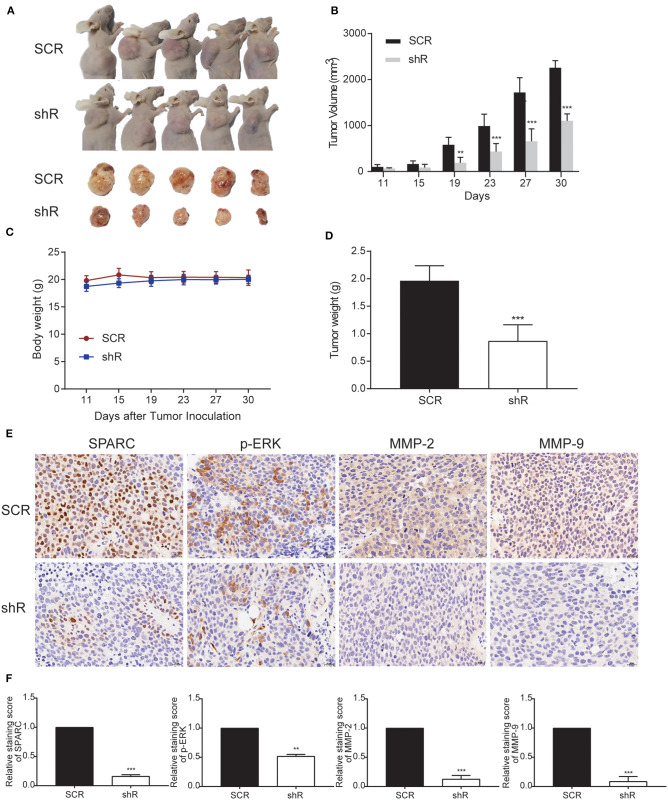
Downregulation of SPARC limits the growth of tumors in vivo. (A) BALB/C nude mice underwent a subcutaneous transplantation in their right upper sub-axillary with SCR or shR lentiviruses-infected HuH-7 cells (n = 5). The deficiency of SPARC suppressed the growth of tumors in nude mice 30 days after the transplantation. (B) The volume of tumors is expressed as the mean ± S.E.M. (C) Body weight. (D) Tumor weight. Immunohistochemistry (400 × magnification) analysis facilitated the detection of the expression levels of SPARC, p-ERK, MMP-2, and MMP-9 in tumor tissues (E,F). **p < 0.01, and ***p < 0.001.